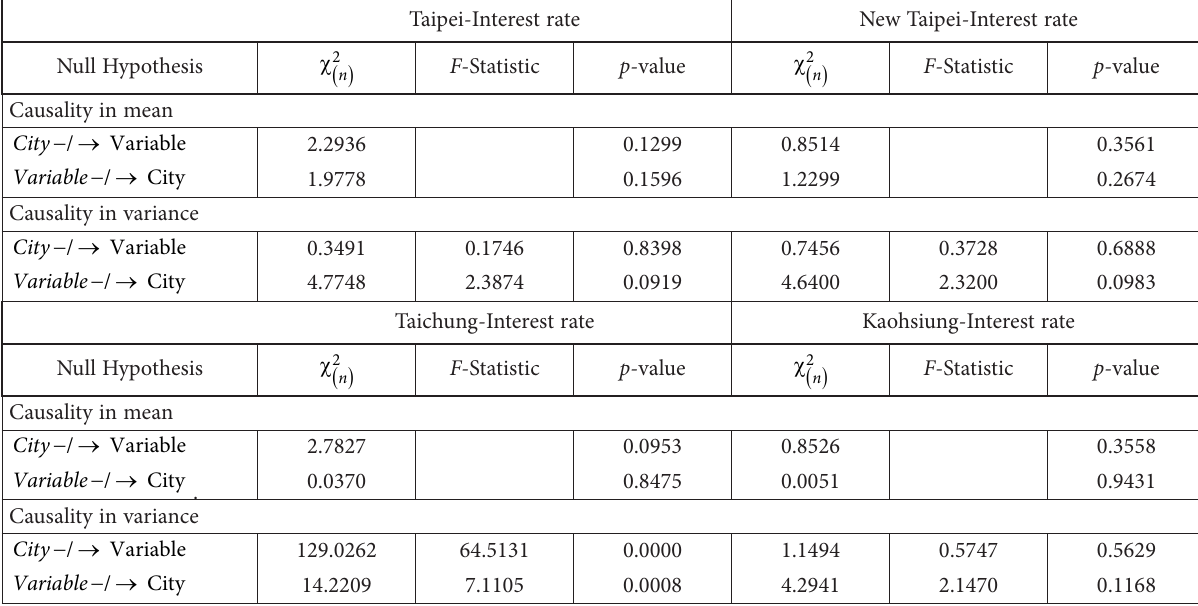
Table 11. Relationship between the interest rate and the housing market Taipei-Interest rate New Taipei-Interest rate